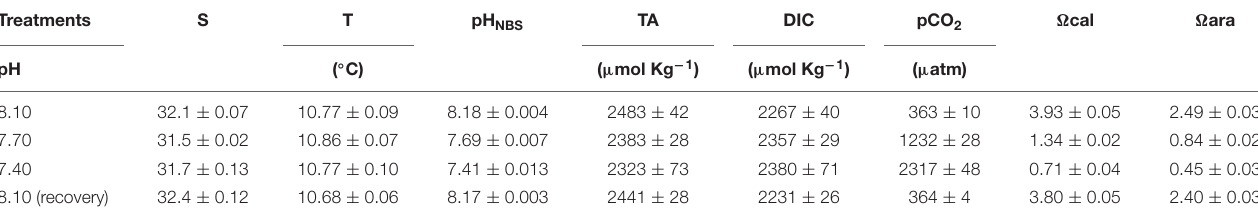
TABLE 1 | Carbonate chemistry of seawater during the incubation of brown crabs, C. pagurus at different CO 2 concentrations ( n = 12). Treatments